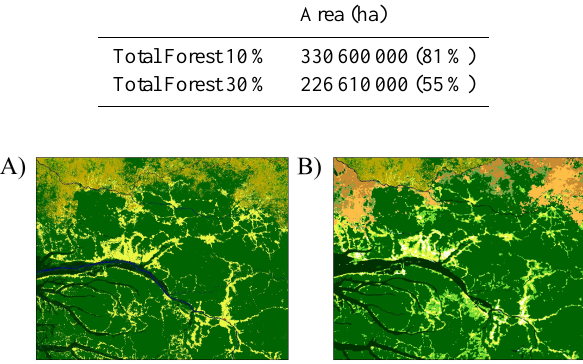
Fig. 11. Road network (OFAC database) is consistent with the spa- tial distribution of the rural complex class near the Atlantic coast.